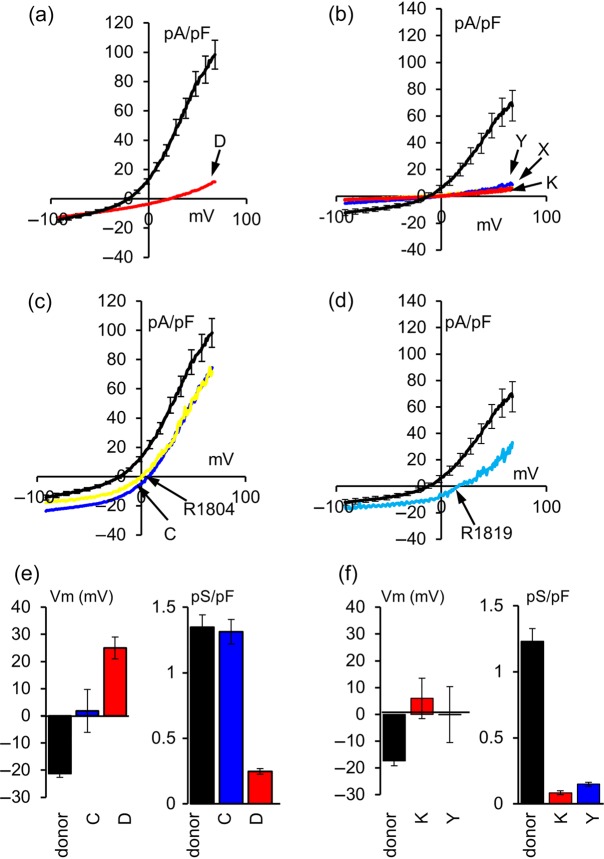
Abnormal current–voltage relationships in spermatozoa from patients. Mean I–V relationships for (a) one IVF patient (Patient D) and (b) three ICSI patients (Patients Y, X and K) in which outward conductance was negligible. Black plot shows the mean I–V (±SEM) for donor samples prepared under the same conditions. The mean I–V relationships for (c) two IVF patients (Patients C and R1804) and (d) one ICSI patients (Patient R1819) in which outward conductance was ‘normal’, but increased inward conductance caused depolarization of Vm. Black lines show mean I–V (±SEM) for donor samples prepared under the same conditions (see the Materials and Methods section). (e) Mean ± SEM Vm (left panel) and Gm (right panel) for cells from IVF Patients C (n = 5 cells) and D (n = 13 cells) compared with mean of all control donor cells prepared under the same conditions (n = 49 cells). (f) Mean ± SEM Vm (left panel) and Gm (right panel) for cells from ICSI Patients K (n = 8 cells) and Y (n = 3 cells) compared with the mean of all control donor cells prepared under the same conditions (n = 27 cells).